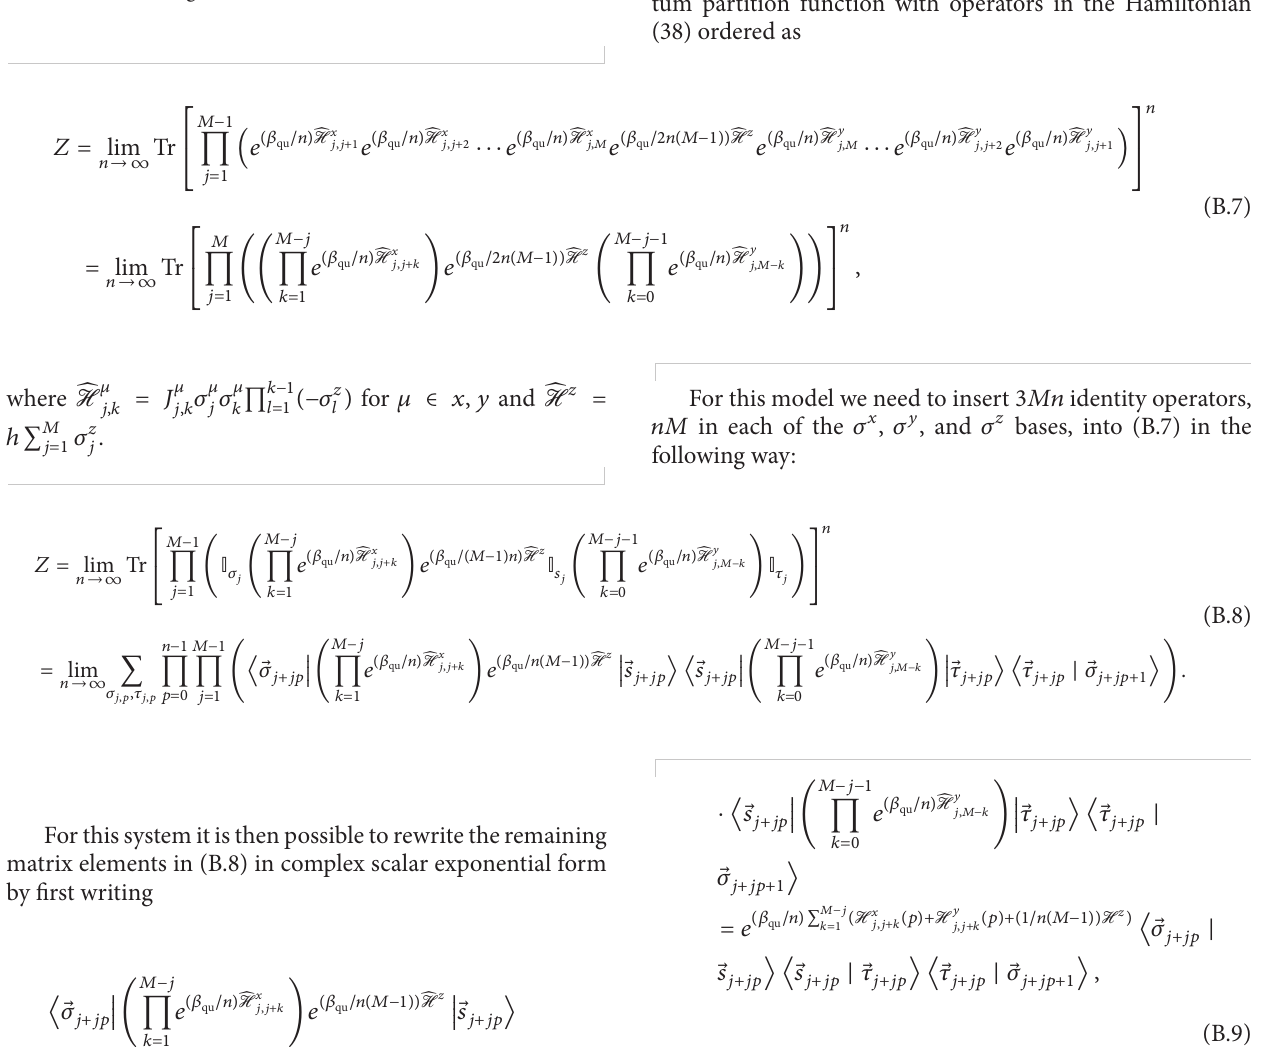
Figure 5: Lattice representation of a class of classical systems equivalent to the class of quantum systems (1) restricted to nearest and next nearest